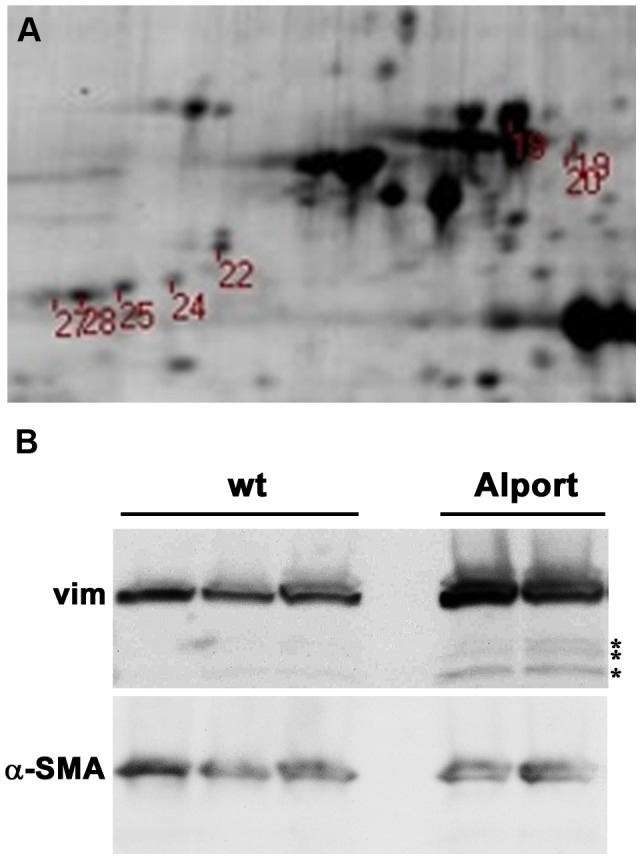
The intermediate filament protein vimentin is upregulated in Alport glomeruli.A: A digital scan of a portion of the 2D gel showing the position of the 8 vimentin spots robotically picked for LC-MS/MS. B: Western blot of wild-type (wt) or Alport mouse glomerular lysates harvested at 4 weeks of age probed with goat anti-vimentin IgGs (Vim, upper blot), then stripped and re-probed with mouse anti-smooth muscle actin (α-SMA, lower blot) as a loading control. Asterisks (*) indicate lower molecular weight bands that are more prominent in the Alport glomerular lystates, possibly representing proteolytic fragments of vimentin.